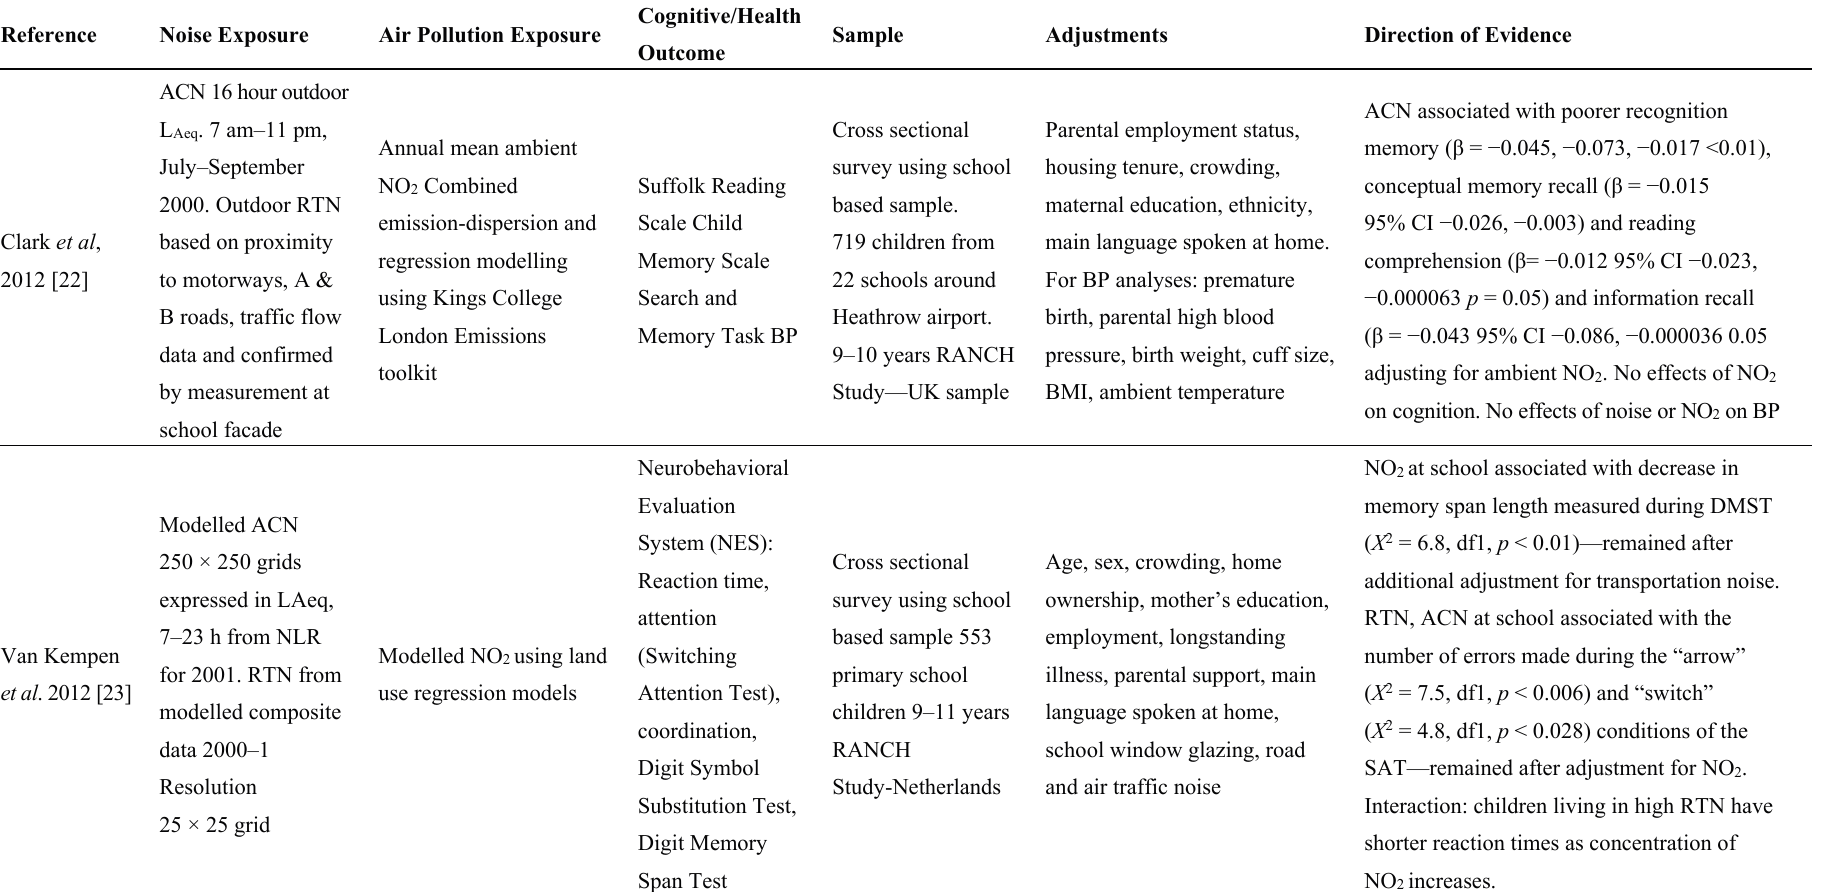
Table 2. Environmental noise, air pollution and cognitive outcomes and blood pressure in